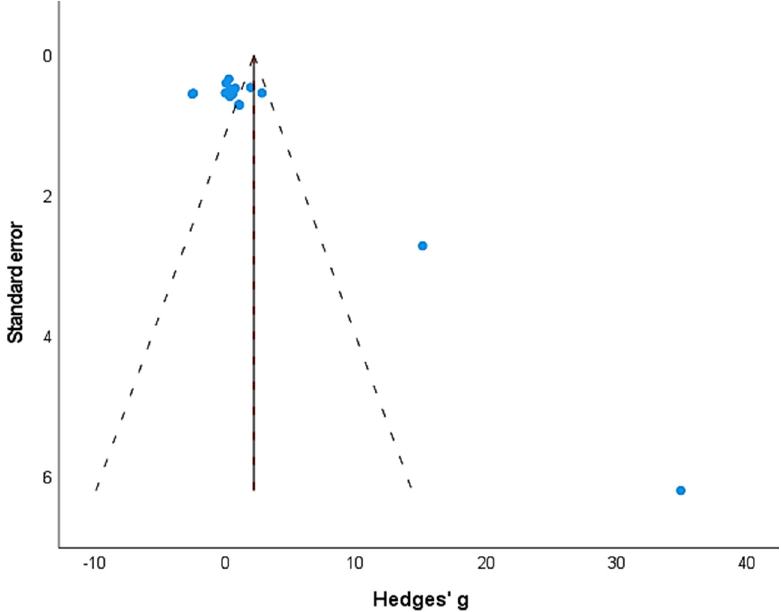
Figure 3. A trim-and-fill funnel plot illustrating the publication bias. Each study is represented by an individual blue circle. The funnel plot area covers 95% of the pseudoconfidence intervals. The vertical midline represents the estimated overall effect size (i.e., observed + imputed studies).